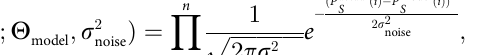
S2 Fig. Experiment 1: Examining the consistency of context effect across different sub- groups of subjects. It is possible that context effect on the 50% probability estimates (Fig